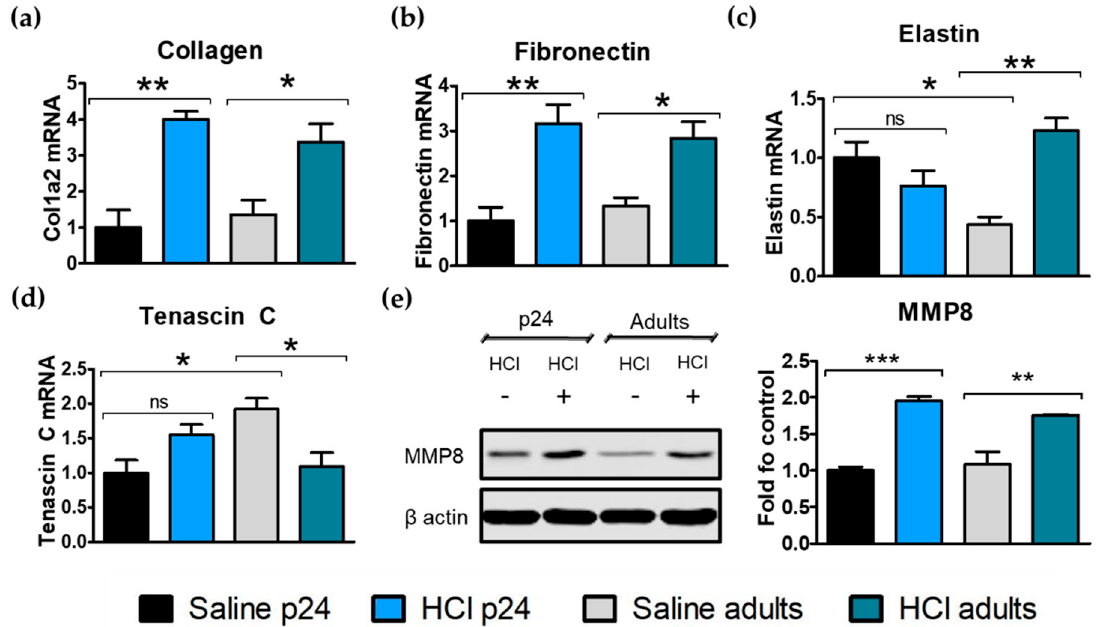
Figure 6. Age-related differences in the extracellular matrix protein deposition. ( a ) Collagen 1a2; ( b ) fibronectin; ( c ) elastin and ( d ) tenascin C mRNA expression levels in the lung computed by real-time PCR. ( e ) Matrix metalloproteinase-8 (MMP8) protein expression estimated by immunoblotting and normalized to β -actin. Means ± SEM, n = 3–5; ns—non-significant; * p < 0.05; ** p < 0.01, *** p < 0.001 with one-way ANOVA and Tukey’s test.